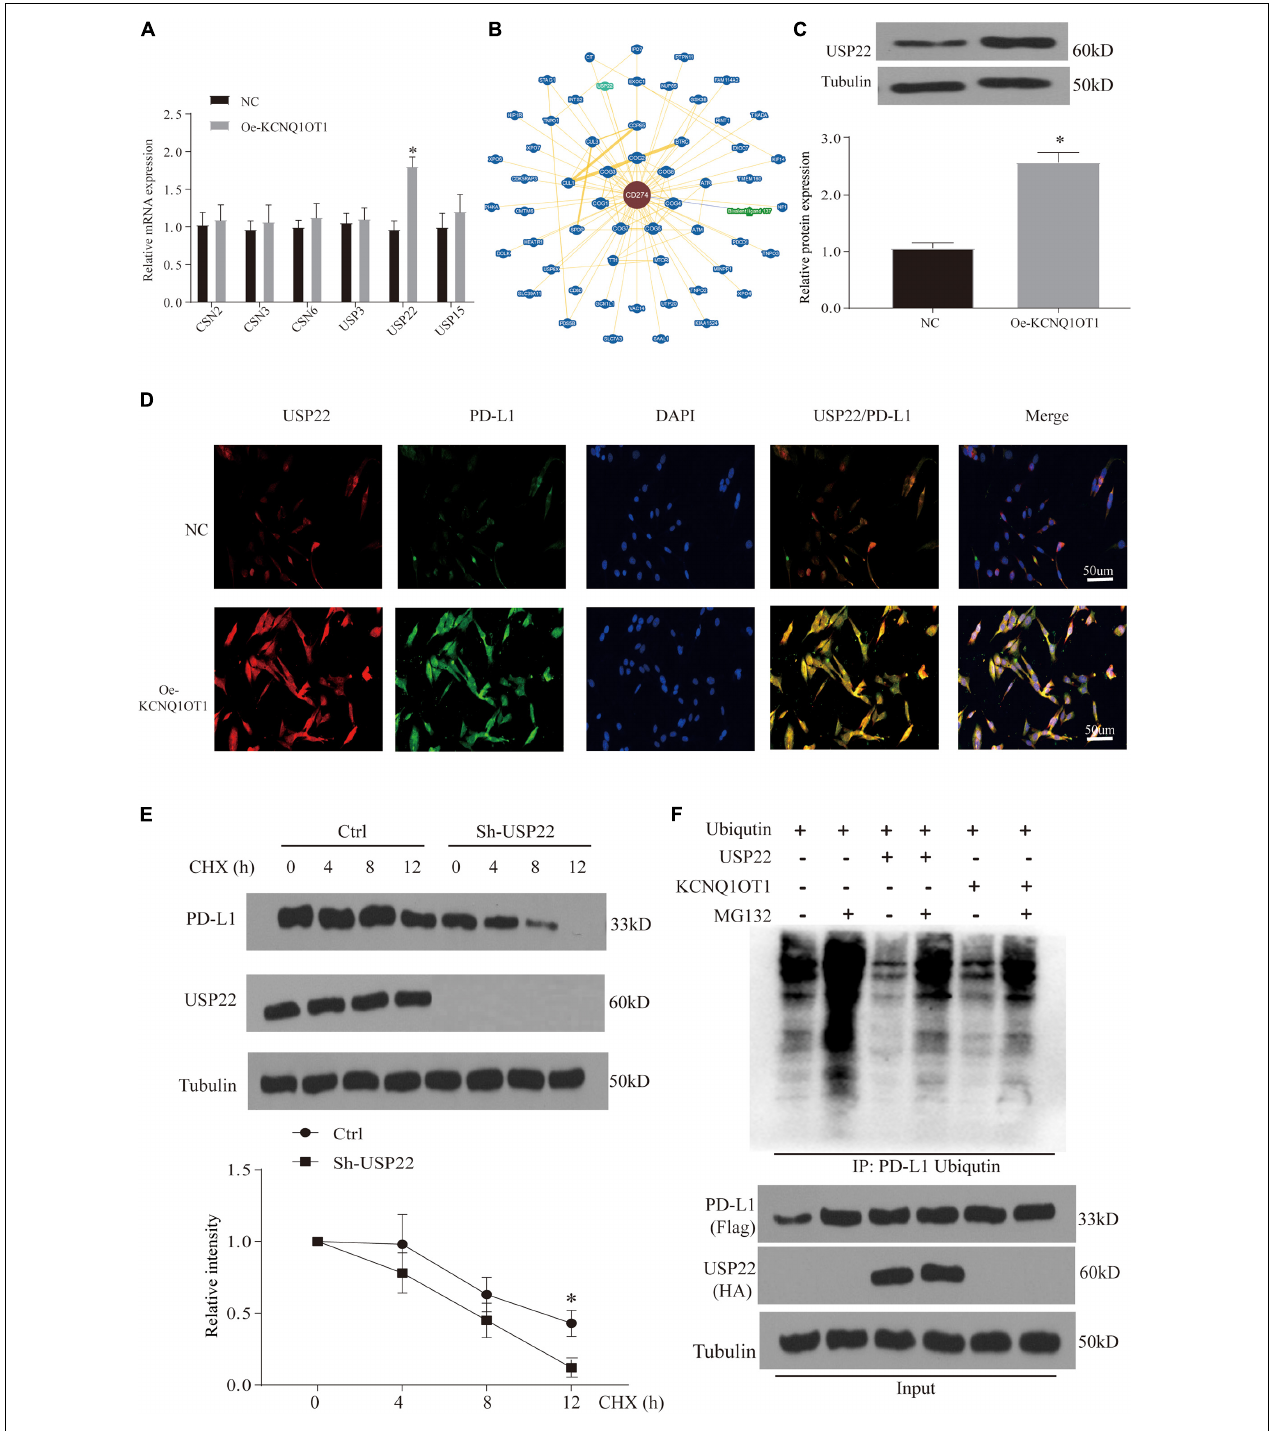
FIGURE 7 | Ubiquitination is involved in the immune escape phenomenon regulated by programmed death-ligand 1 (PD-L1). (A) Quantitative reverse transcription PCR (RT-qPCR) analysis of the deubiquitinating enzymes in SW1463 cells; glyceraldehyde 3-phosphate dehydrogenase (GAPDH) is used as an internal reference gene. (B) Interaction network of PD-L1 analyzed in BioGRID database. (C) Differential expression of ubiquitin-specific peptidase 22 (USP22) protein in different treatment groups of tumor tissues. (D) Immunofluorescence staining of USP22 (red) and PD-L1 (green) in SW1463 cells. Scale bar, 30 µ m. (E) PD-L1 protein half-life determination in SW1463 cells lacking USP2. Before Western blot analysis, cells were co-incubated with cycloheximide (CHX, 50 µ g/ml) at the specified time points. (F) After treatment with 10 µ M MG-132 for 3 h or 8 h, the ubiquitination of PD-L1 in HEK293 cells was determined. Cells were transfected with ubiquitin after different treatments. The ubiquitinated PD-L1 was subjected to immunoprecipitation (IP) before Western blot analysis with ubiquitin antibody. ∗ p < 0.05 compared with the NC group.